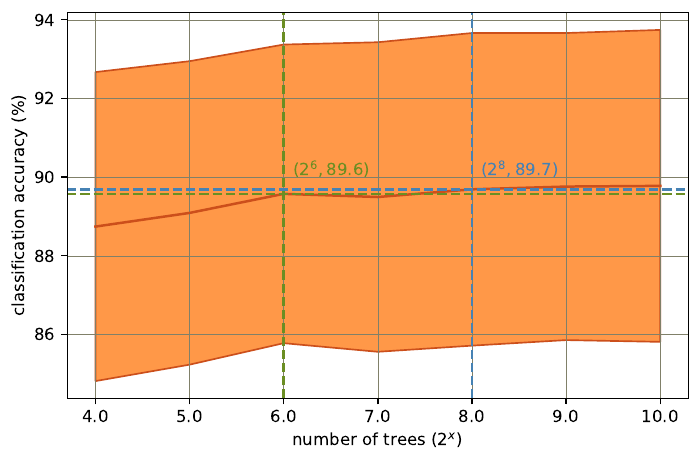
Figure 2. Classification accuracy versus the binary logarithm of the number of trees. The shaded areas highlight ± one standard deviation from the mean